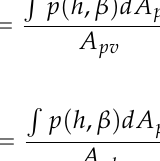
k with the half-included angle of the conical H